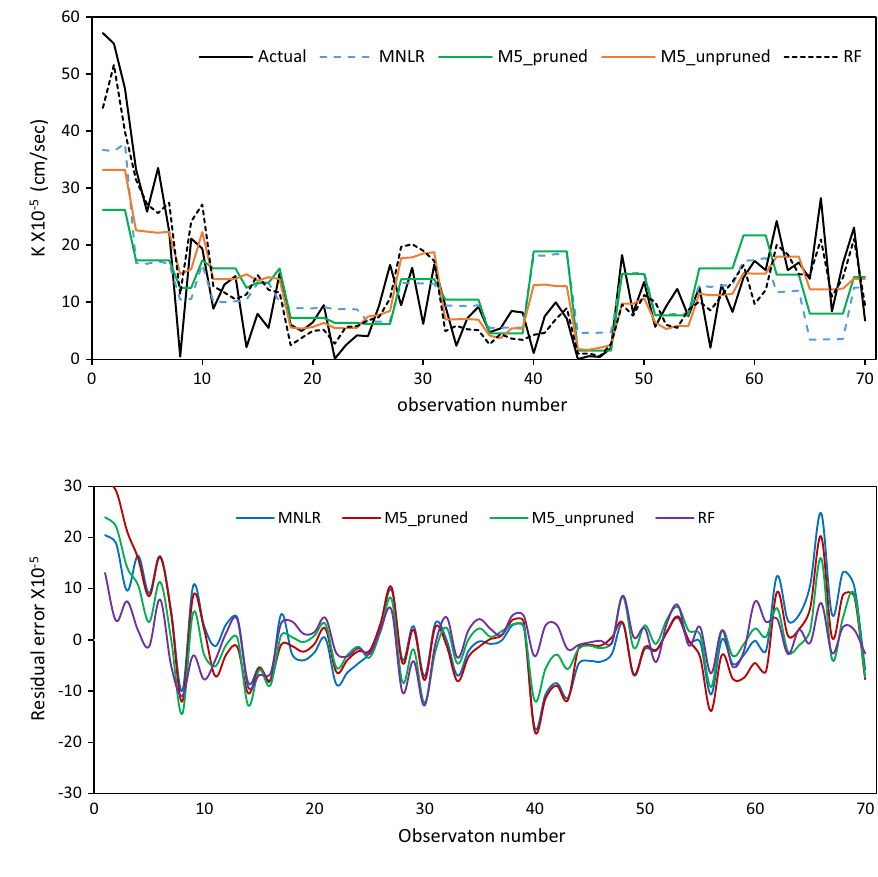
Fig. 8 Scattering of actual and soft computing model-based predictions against observation